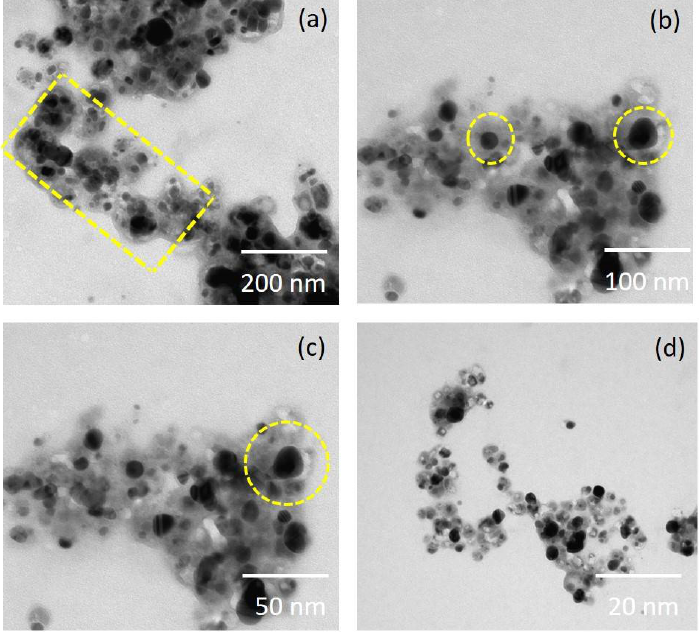
Figure 3. Ahigh-resolution scanning electron microscope (HRSEM) image of the silver nanoparticles derived from marine Streptomyces sp. Al-Dhabi-87. ( a ) HRSEM at 200 nm ( b ) HRSEM at 100 nm ( c ) HRSEM at 50 nm ( d ) HRSEM at 50 nm